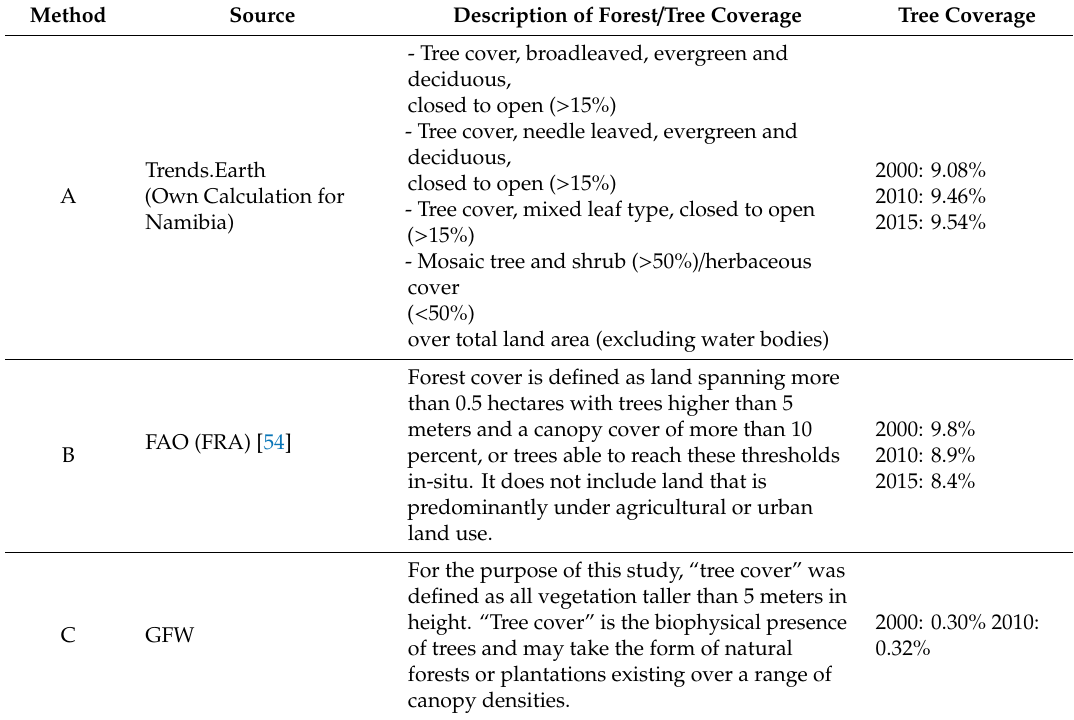
Table 10. Forest / Tree Coverage Namibia 2010 and